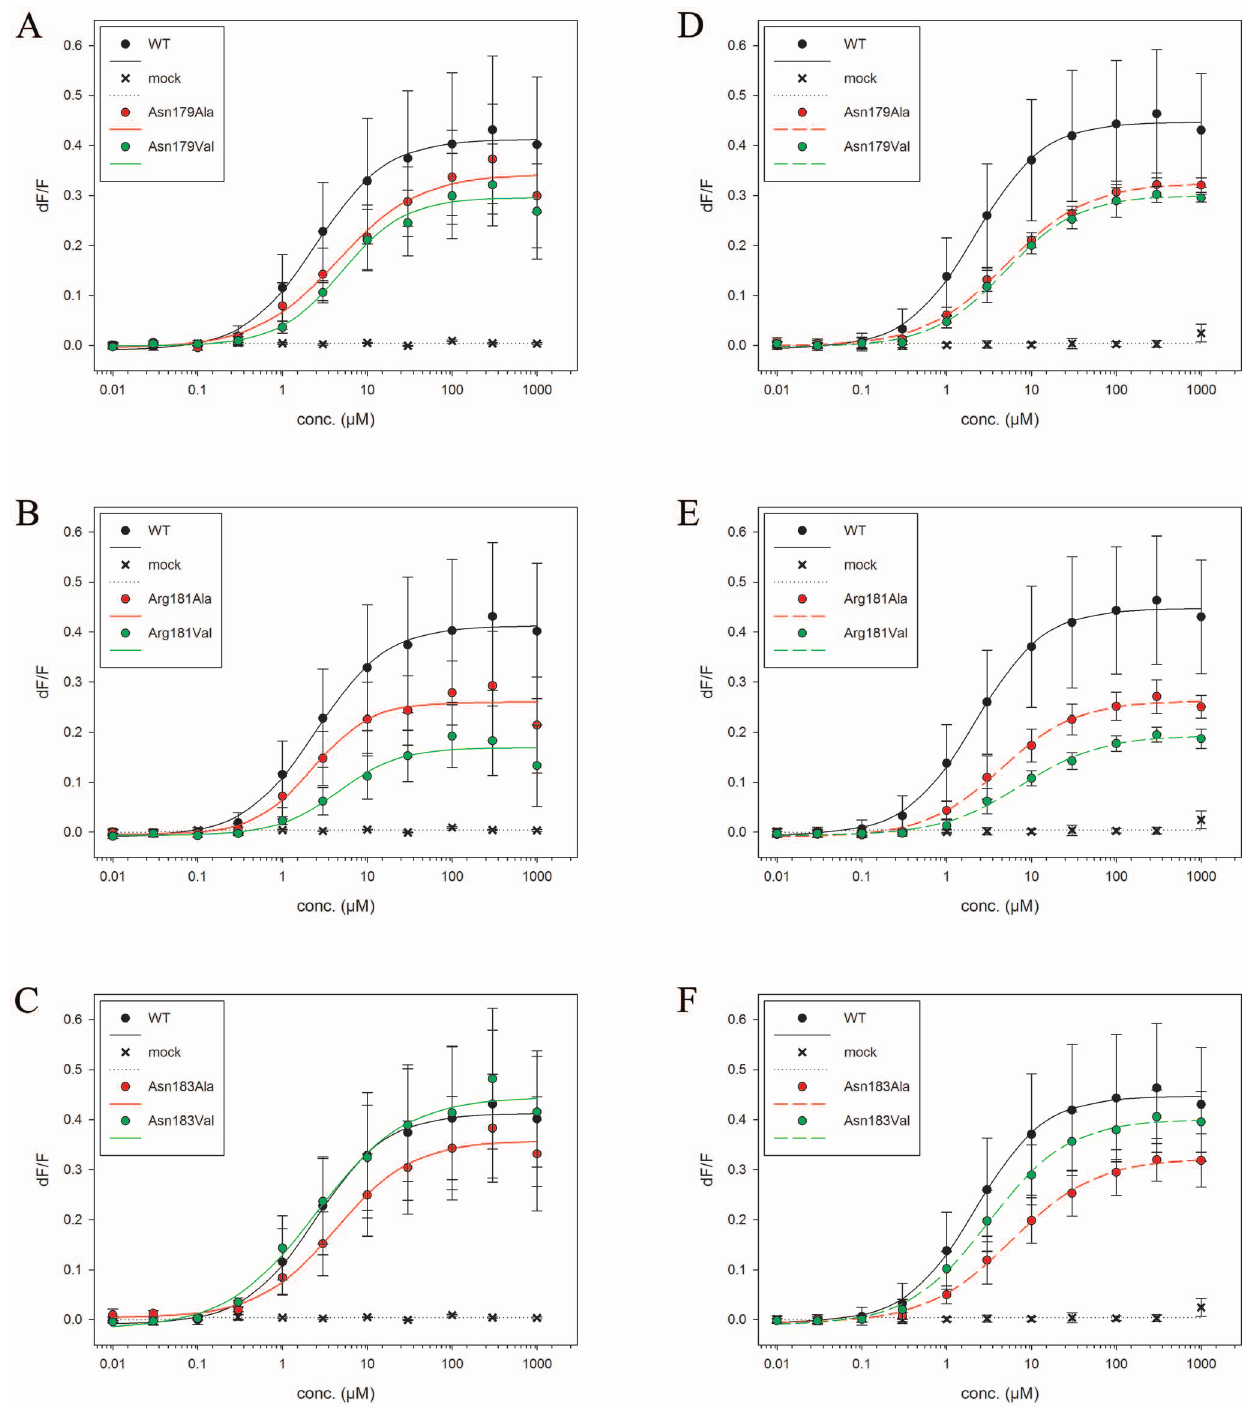
Figure 4. Dose-response curves. Dose-response curves of TAS2R38 wild type and mutants after stimulation with increasing PTC and PROP concentrations (0 to 1000 m M). Each point corresponds to the mean 6 standard deviation. The mean is calculated from at least three independent experiments. A–C) PTC application, D–F) PROP application. disrupt the H-bond with Ser260 observed in the PTC adduct. The tently, this mutation produced a severely impaired activation upon PTC application and an almost failed activation upon PROP latter could play a role in shaping the binding cavity (Fig. 3). The application (Fig. 6D and I). (v) The TAS2R38-Trp201Phe mutant EC 50 of the adduct with PTC is larger than that of WT (Fig. 6D might affect the p - p stacking interactions (with both the agonists) and I). Upon PROP application, we observe an almost complete due to the intrinsic difference between the two residues, and also loss of function of the receptor. (vi) The TAS2R38-Ser260 residues